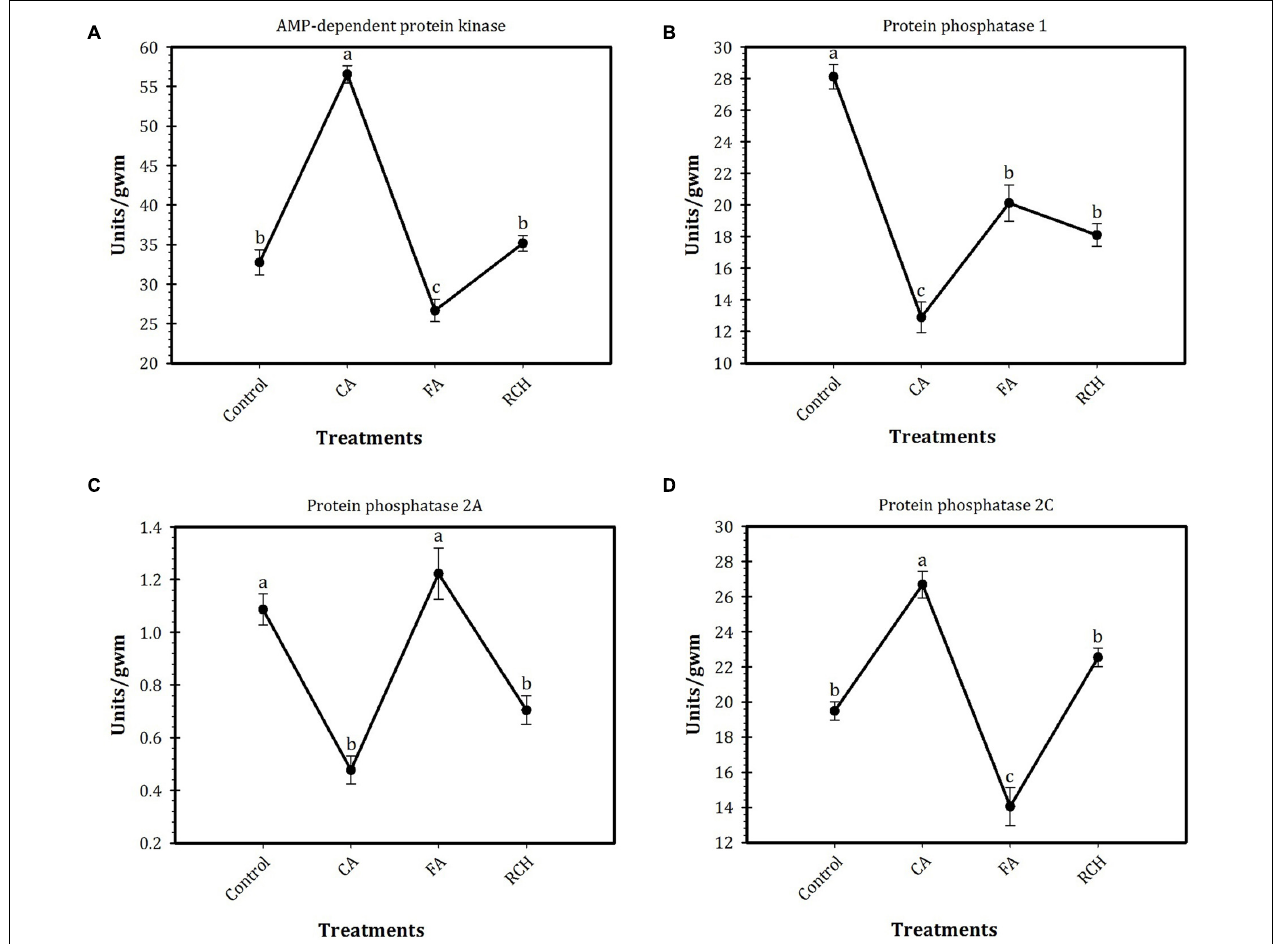
FIGURE 1 | Profiles of AMP-dependent protein kinase (AMPK) and protein phosphatase (PP) activities in Trogoderma granarium fourth instar larvae following different thermal regimes. (A) total PKA, (B) total PP1, (C) PP2A, (D) PP2C. Each point is an average of five replications. The means followed by different letters are significantly different (Turkey’s test, P <